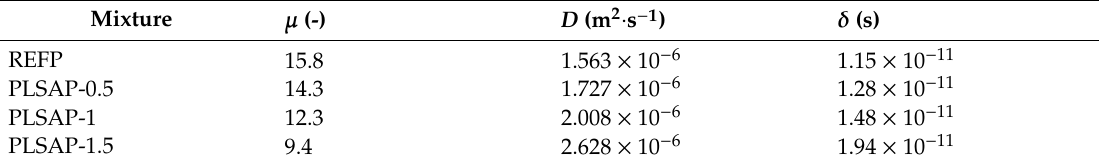
Table 4. Water vapor transport properties of studied plasters.